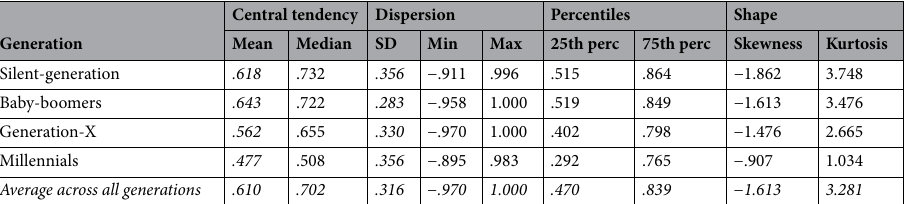
Table 1. Ipsative stability of the within-person value-type hierarchies (i.e., value-profile stability) in the period 2008–2020 within 4 generations and for all individuals. Significant values are in